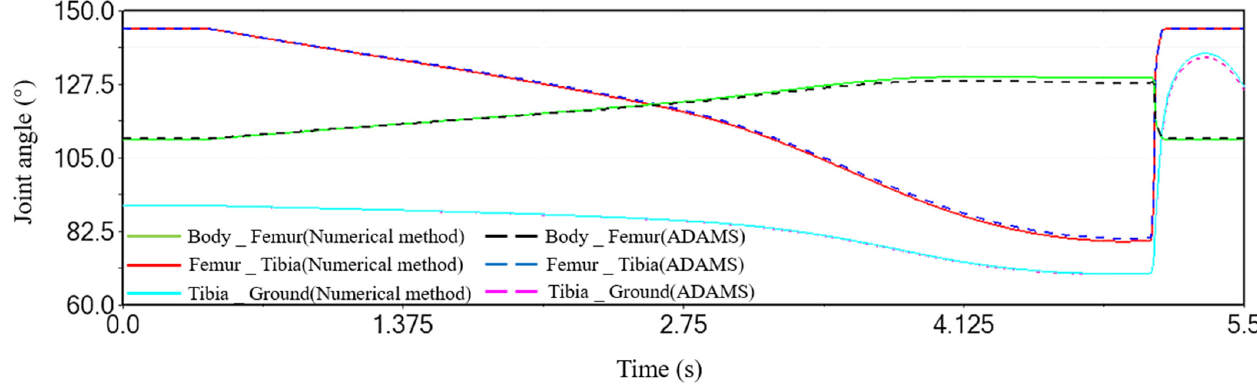
10 of 16 Table 1. Relevant parameters for robot components. Components